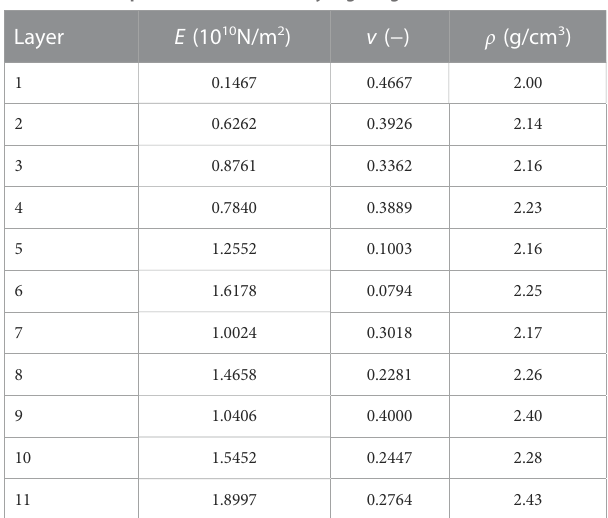
FIGURE 4 The fl ow chart of direct pre-stack inversion of elastic modulus using the exact Zoeppritz equation.